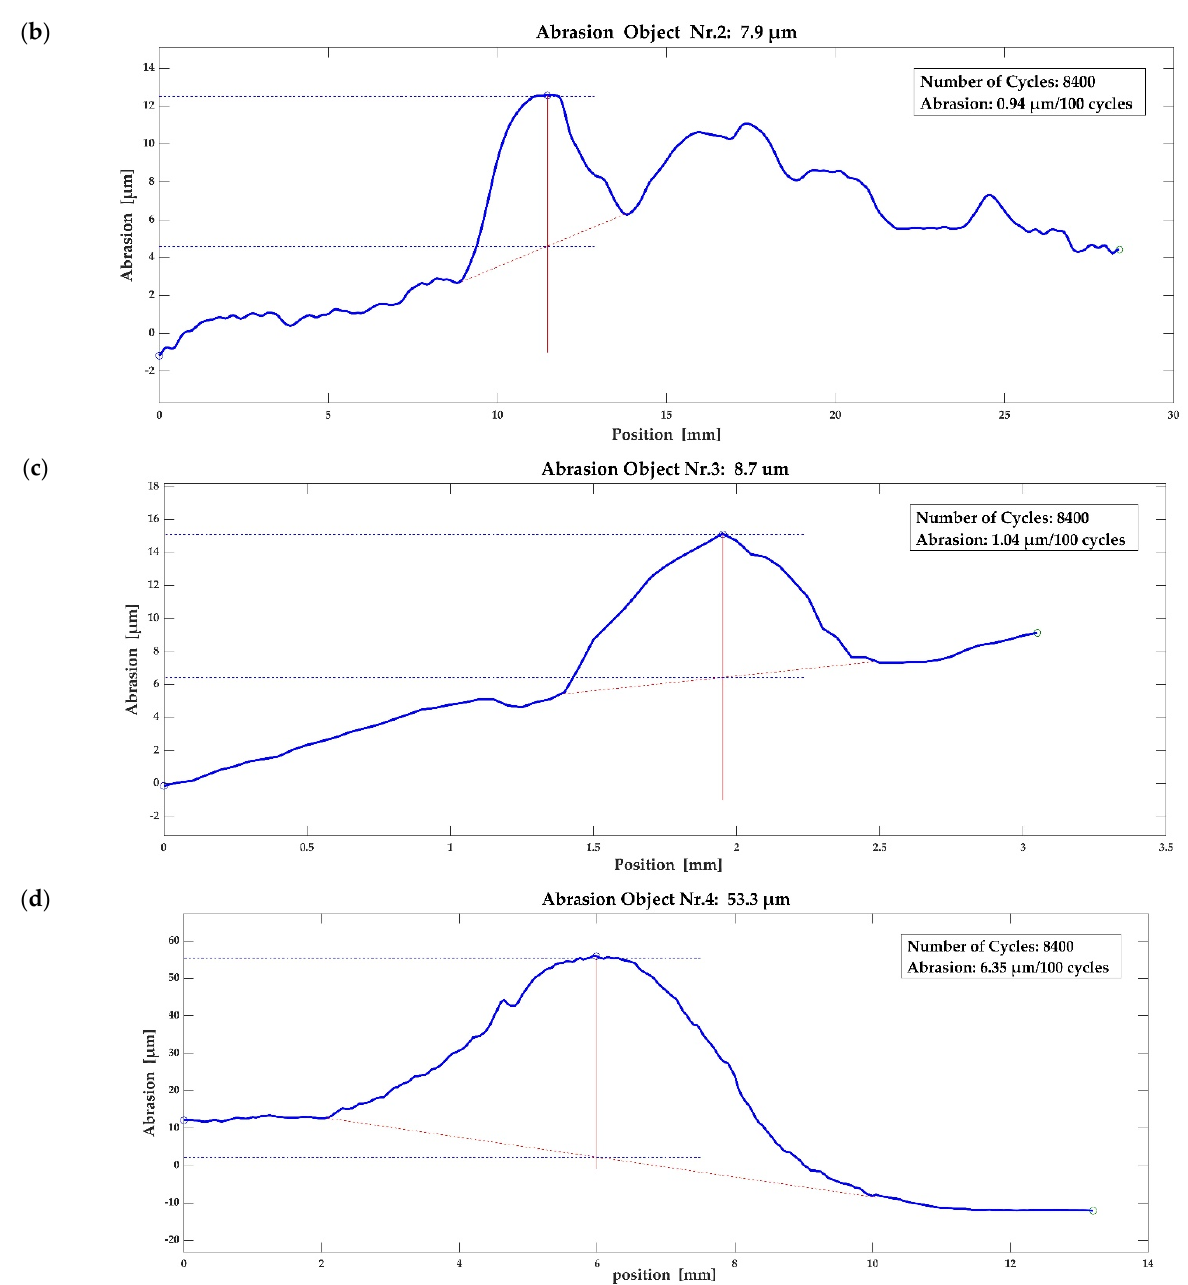
Figure 12. Abrasion measurement curves: ( a ) test object 1, including additional description of the sections of the curve; ( b ) test object 2; ( c ) test object 3; ( d ) test object 4. The position along the implant surface (geometric longitudinal axis) is plotted on the x-axis and the deflection (normal distance) of the galvo scanner measuring tip is plotted on the y-axis. The y-axis thus represents the measured abrasion. A standardized abrasion value in µm/100 cycles is exhibited for each object. Sudden, strongly deviating signals in Table correspond to depressions in the surface and are a direct measure of the abrasion occur- ring at this point.